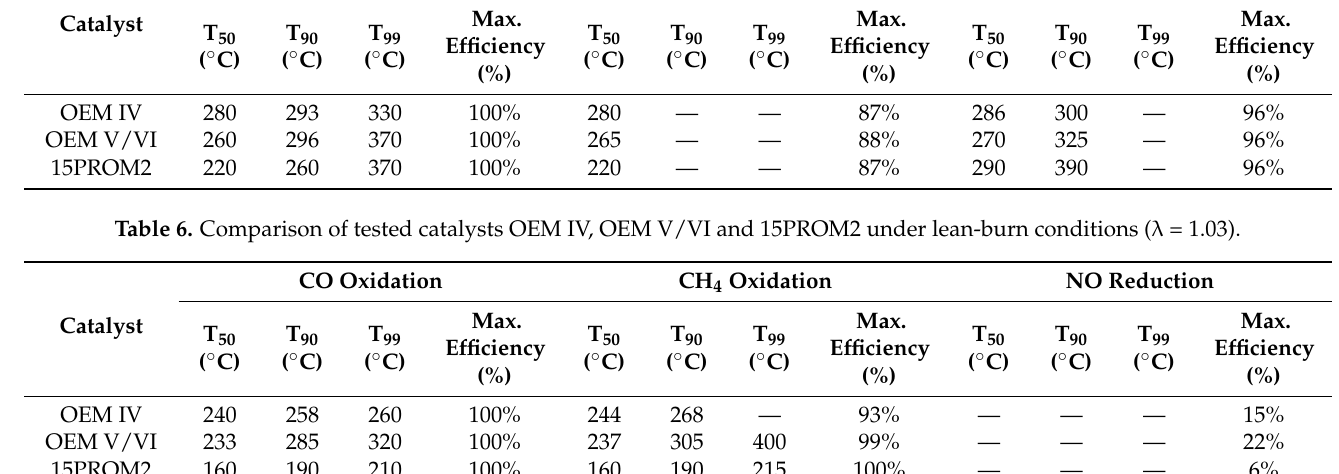
Table 5. Comparison of tested catalysts OEM IV, OEM V/VI and 15PROM2 under rich-burn conditions ( λ = 0.99).